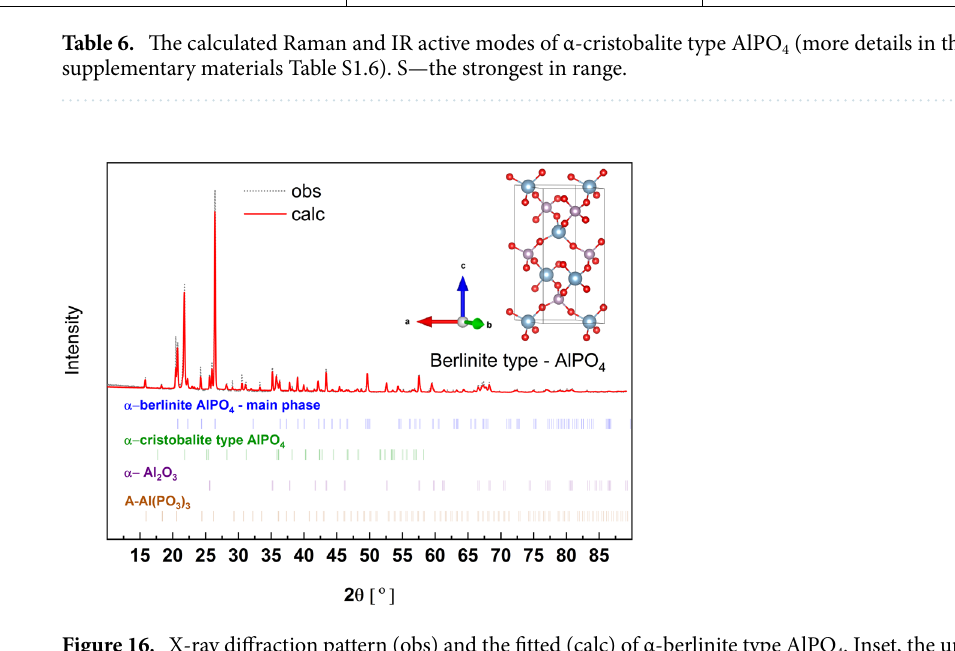
Figure 16. X-ray diffraction pattern (obs) and the fitted (calc) of α-berlinite type AlPO 4 . Inset, the unit cell of the compound with the optimized atom